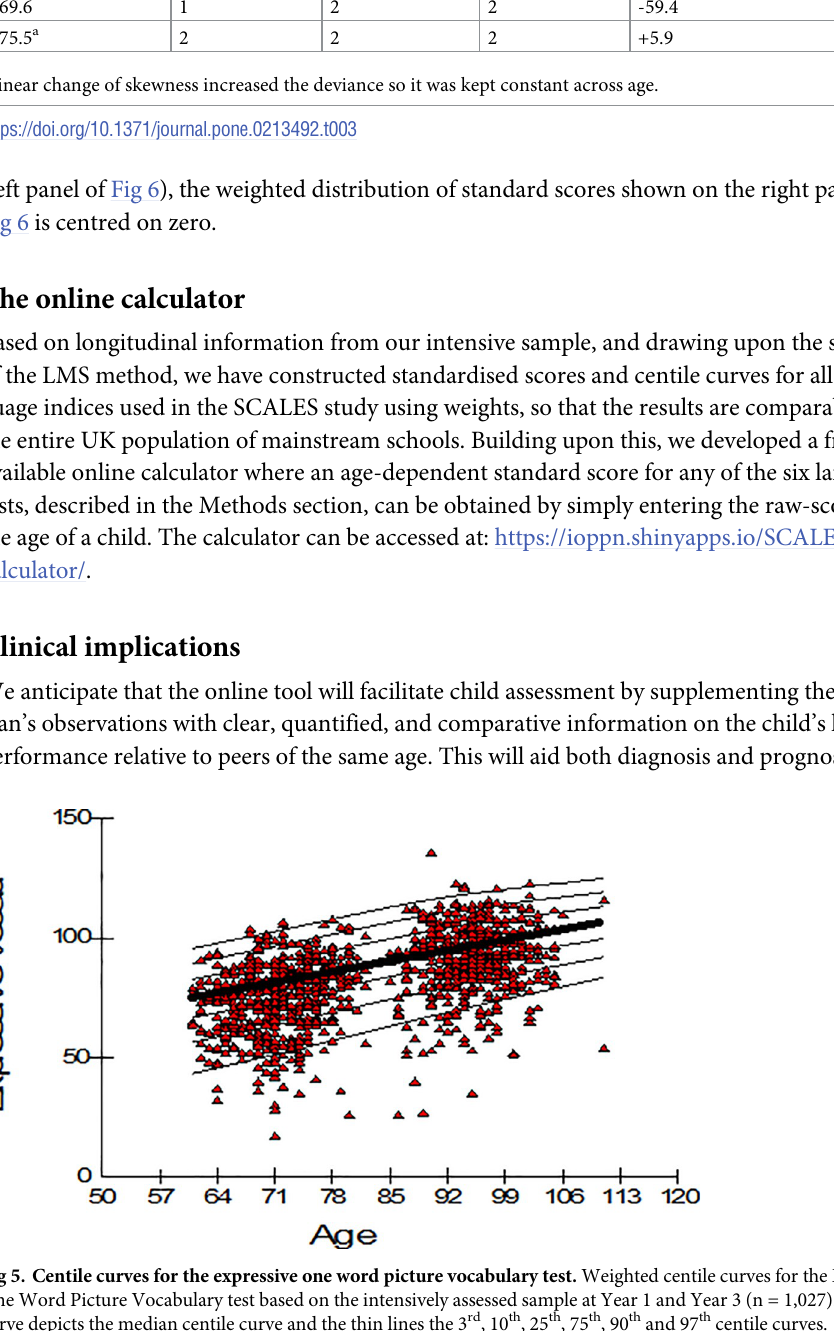
(left panel of Fig 6), the weighted distribution of standard scores shown on the right panel of Fig 6 is centred on zero.